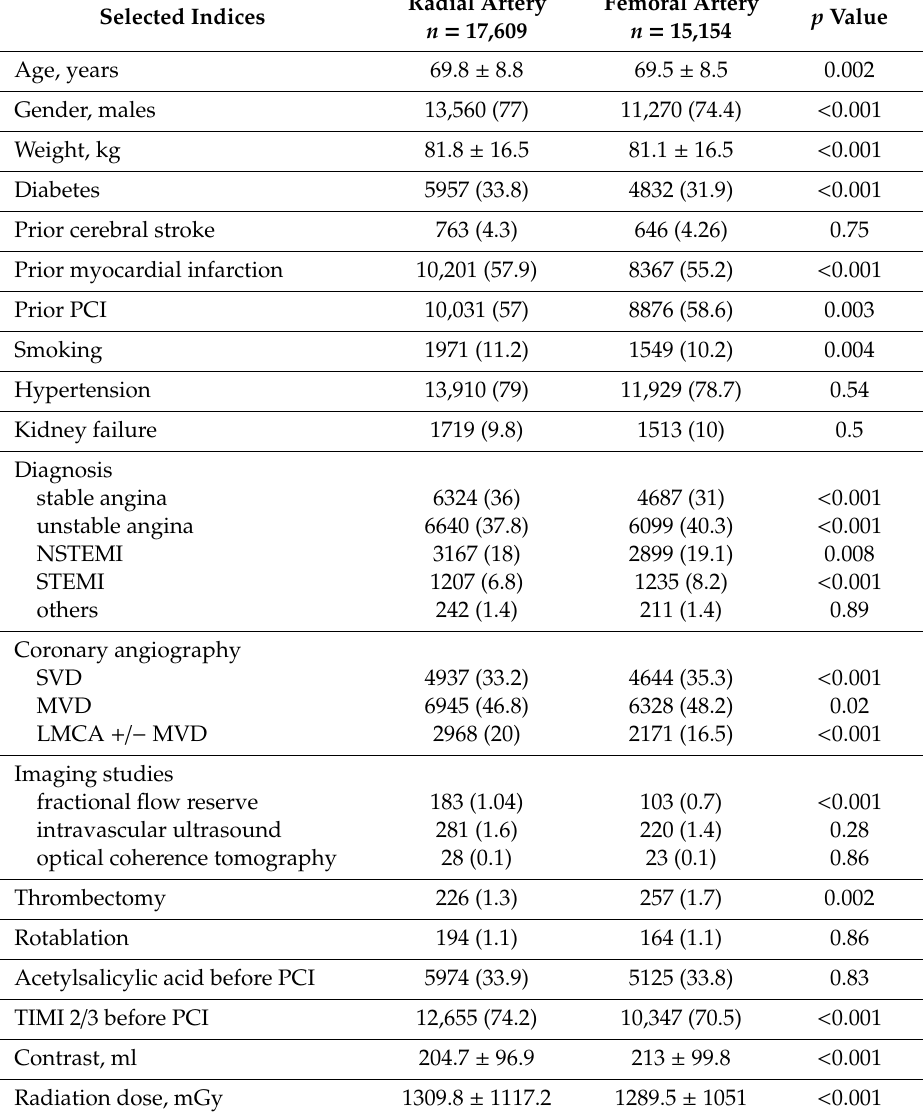
Table 1. General patient characteristics according to radial and femoral access in the overall group of patients prior to propensity score